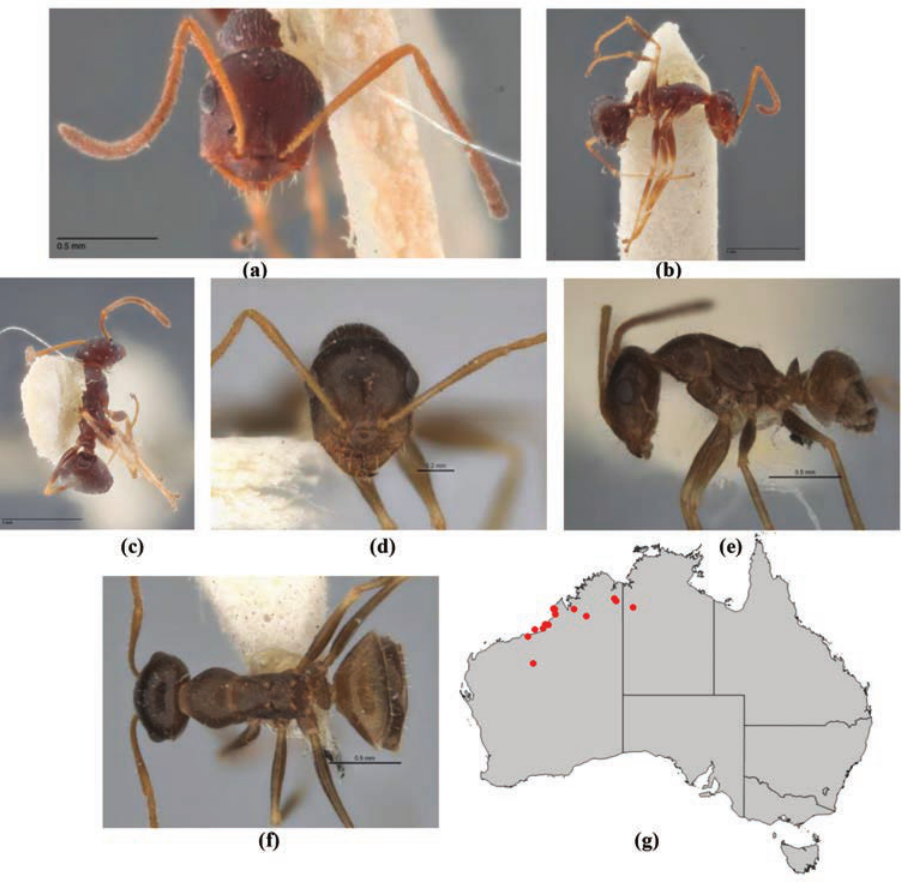
Figure 44. Melophorus mjobergi Forel: NHRS minor worker syntype (NHRS-HEVA 000003949) frons ( a ), profile ( b ) and dorsum ( c ); non–type minor worker (JDM32-004667–bottom ant) frons ( d ), profile ( e ) and dorsum ( f ); distribution map for the species ( g ). Low resolution scale bars: 1 mm ( b, c ); 0.5 mm ( e–f ); 0.2 mm ( a, d